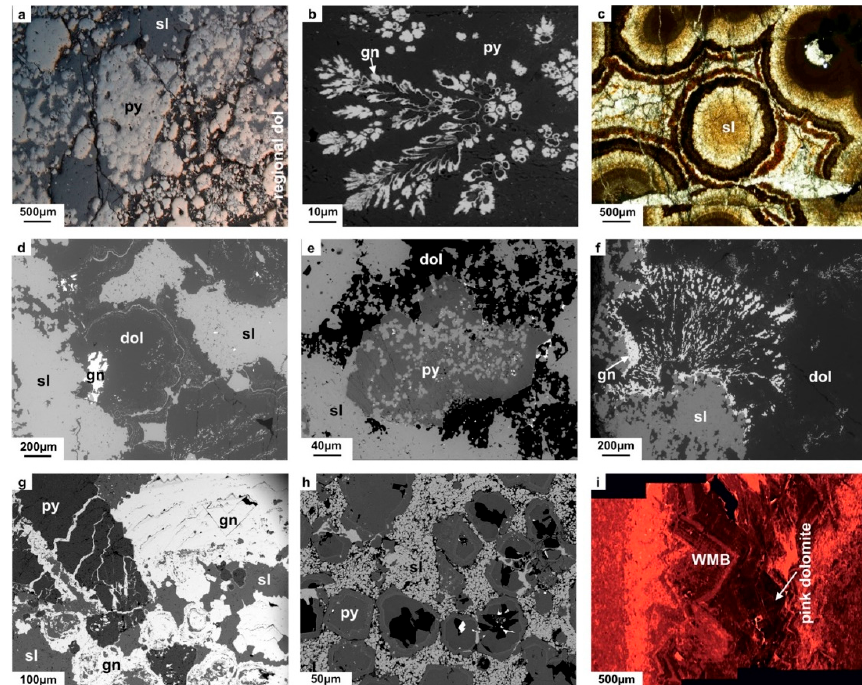
Figure 6. Reflected light, BSE and cathodoluminescence (CL) images of Lisheen deposit mineralization. ( a ) Relicts of primary pyrite (py) partially replaced by sphalerite (sl), Island Pod orebody; ( b ) dendritic pyrite (py) partially replaced by galena (gn), Island Pod orebody (modified from Doran et al. [46]); ( c ) colloform sphalerite, Derryville orebody; ( d ) intergrowth of sphalerite and dolomite (dol) on skeletal galena, Island Pod orebody (modified from Doran et al. [44]); ( e ) sphalerite replacing and filling interstices in pyrite, Island Pod orebody; ( f ) dendritic galena associated with dolomite and sphalerite, Island Pod orebody; ( g ) galena filling fractures in pyrite and replacing sphalerite, Main zone orebody; ( h ) zoned pyrite grain showing Co-As rims, with fracture infilling by sphalerite, Island Pod orebody; and ( i ) earlier regional dolomite overgrown by WMB dolomite and later infilling pink dolomite, Island Pod orebody.